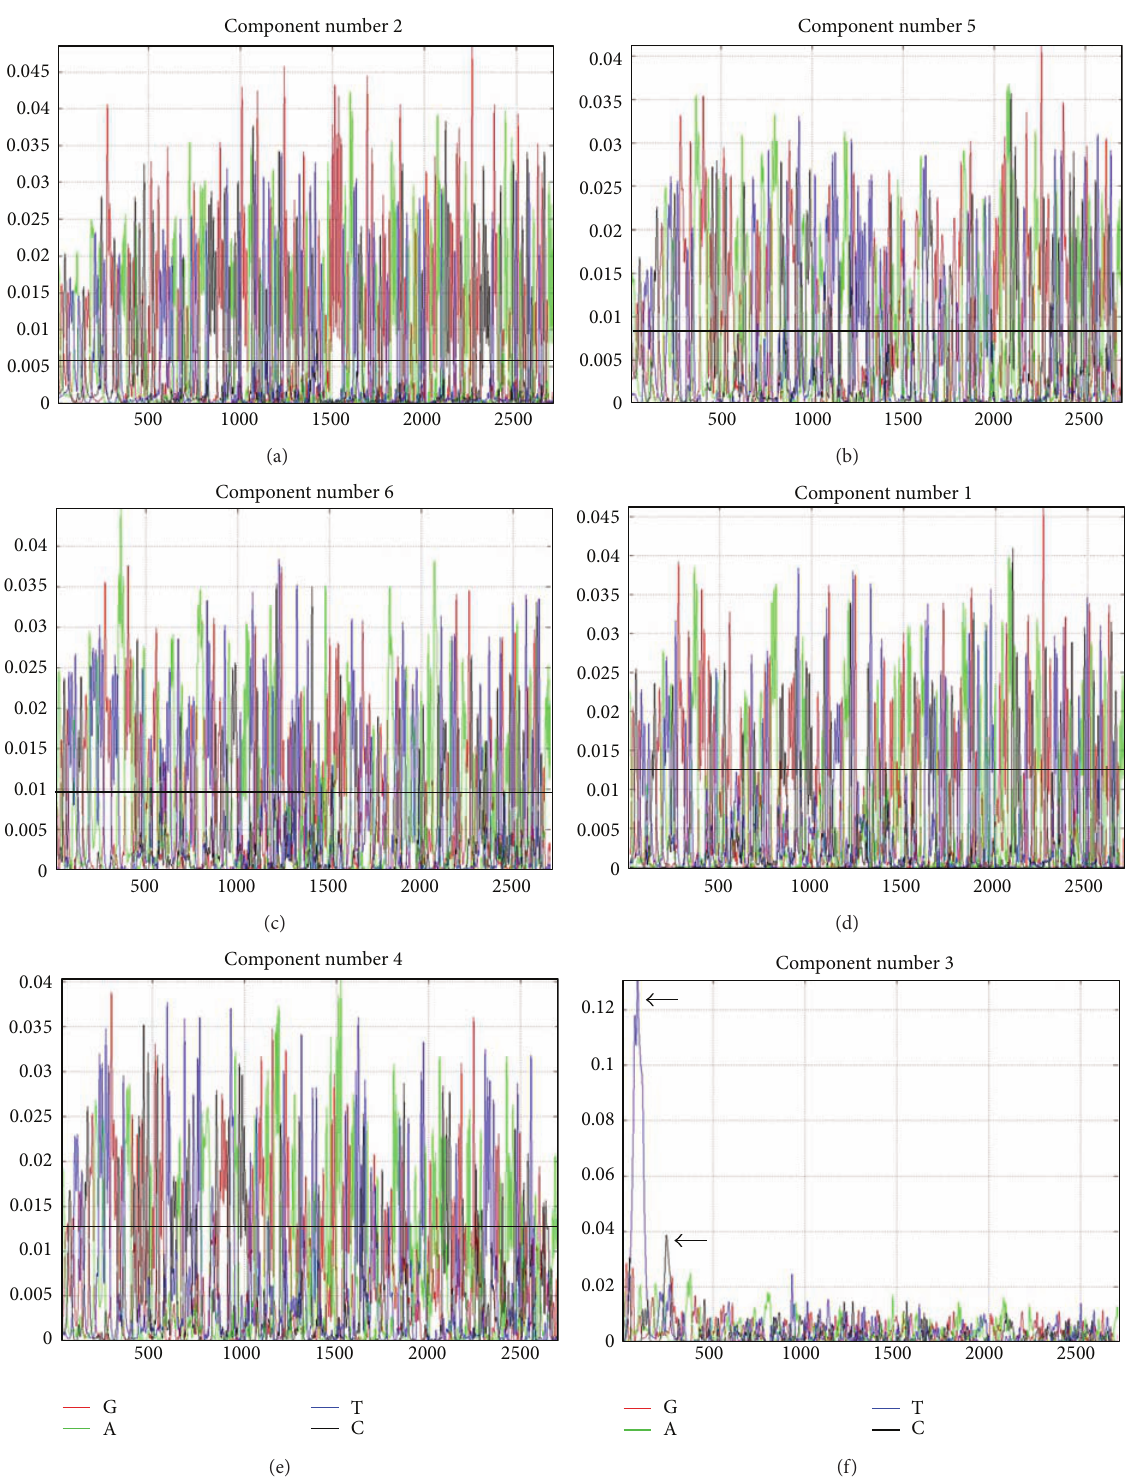
Figure 2: Spectra of the six components resolved by MCR analysis. Visual examination reveal components 2, 5, and 6 ((a)–(c)) to have well resolved spectra with low background sequences. Components 1 and 4 ((d) and (e)) also have well resolved spectra, although with somewhat higher background sequences than components 2, 5, and 6. Component 3 (f) has two high peaks (black arrows) and a poorly resolved